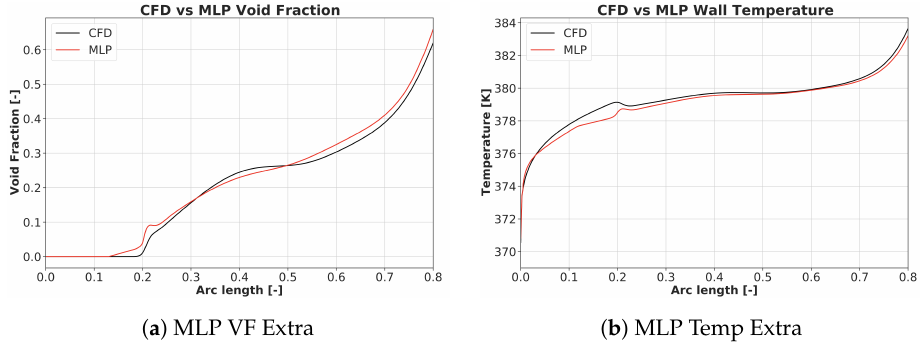
Figure A4. Comparison between CFD and DNN/MLP model predicted void fraction and wall temperature along the arc for an interpolation dataset at q (cid:48)(cid:48) = 40,000 W/m 2 , u = 0.2 ms − 1 . From the plot it can be noted that the MLP model shows overconfident values for the void fraction and under predicted values for the wall temperature. Although the MLP model fails to capture the physics accurately it still showed good trend to that of CFD data.